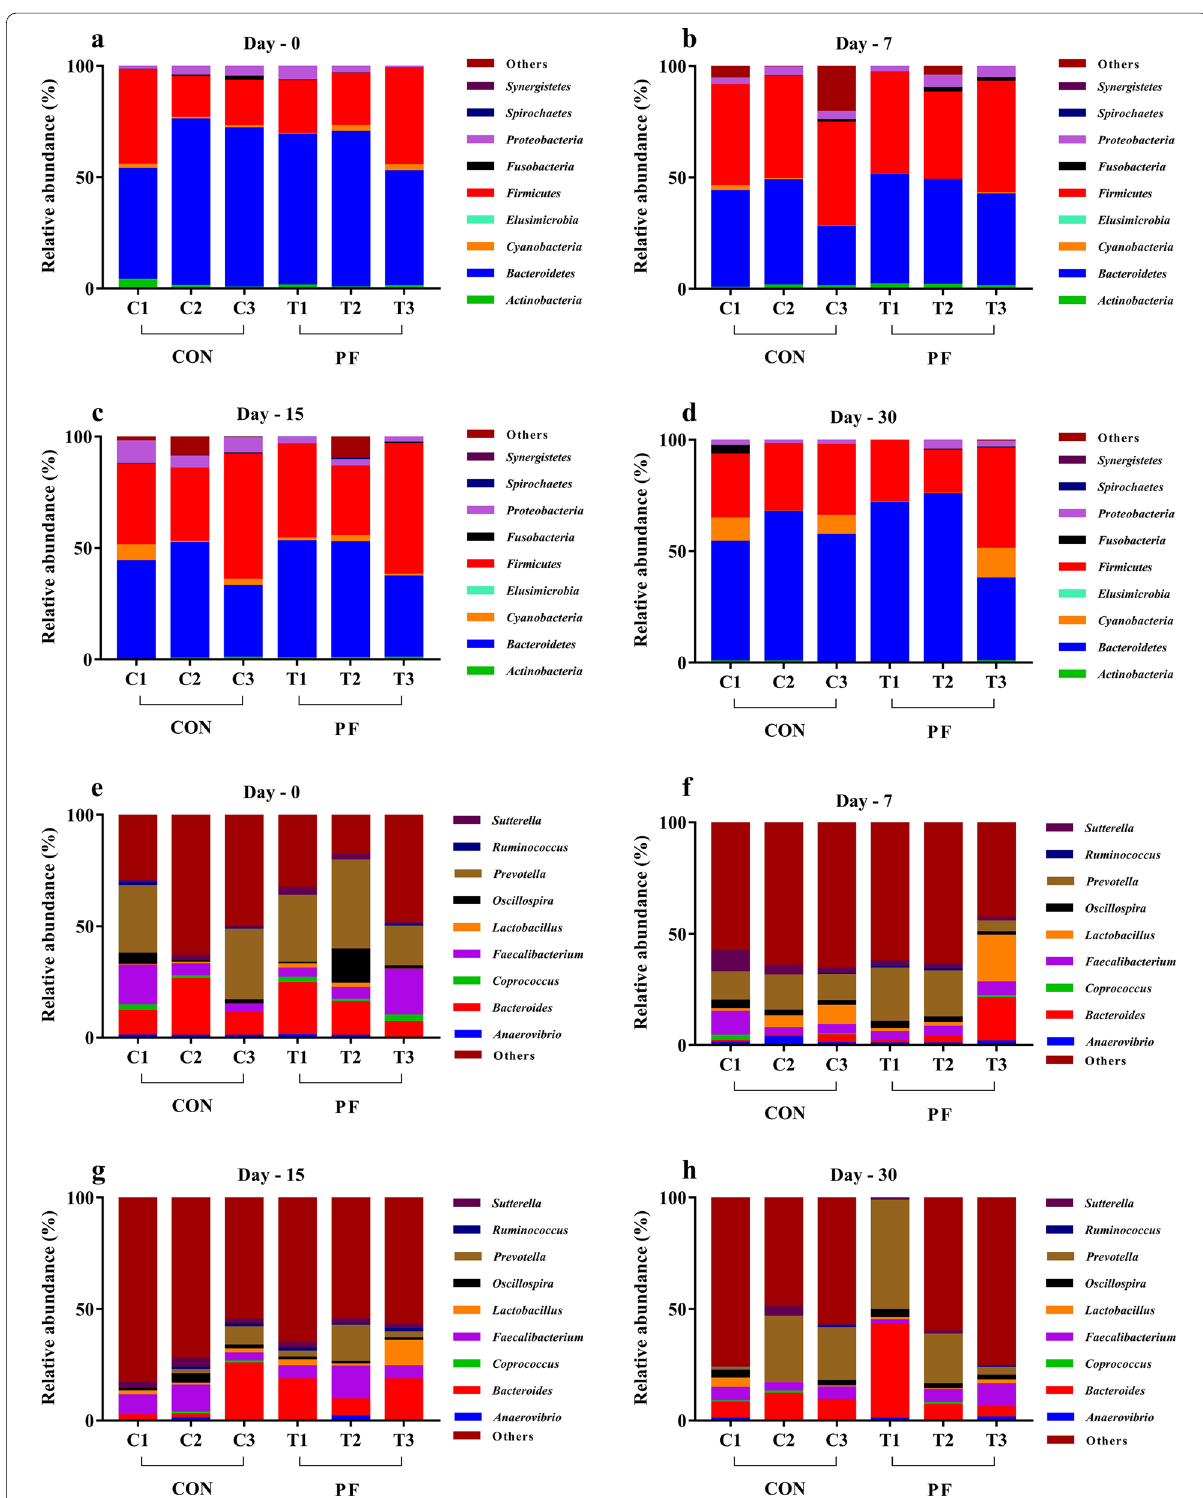
Fig. 8 Change in the relative abundance of fecal bacterial composition of calves determined via 16S rRNA gene amplicon sequencing. Different panels show the composition of the microbial community between the two groups (CON and PF) with respect to the phyla ( a, b, c, and d ) and genera ( e, f, g, and h ) of bacterial. The animal-wise difference between the control and treatment groups at each sampling point (Day 0, 7, 15, and 30) are depicted in the graph. Basal diet with no supplementation (CON), supplemented with L. reuteri BF-E7